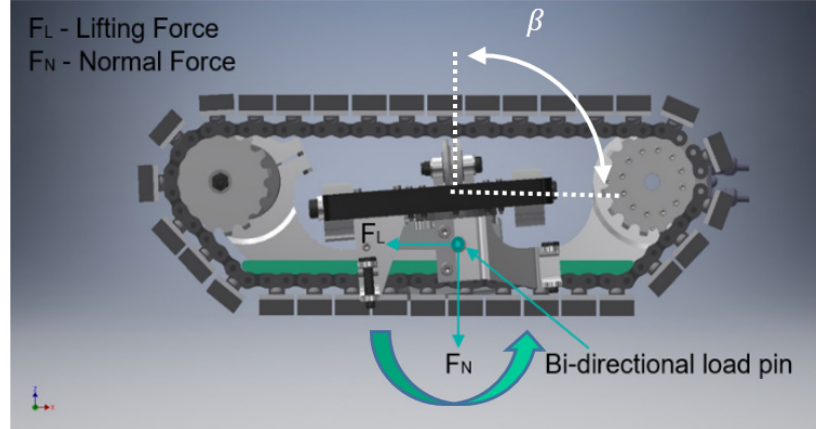
Figure 7. Side-view of the CRR crawler; arrows indicate the alignment axis for a conical-shaped wind turbine tower .